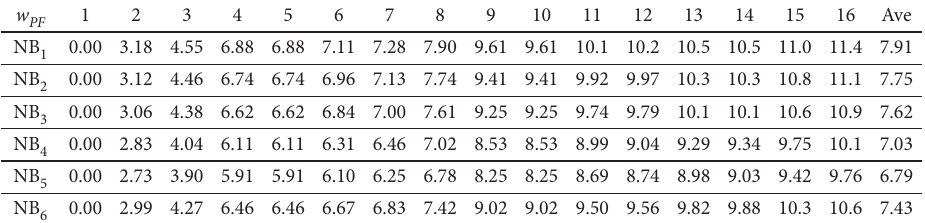
with FS-OWAAC operator PF